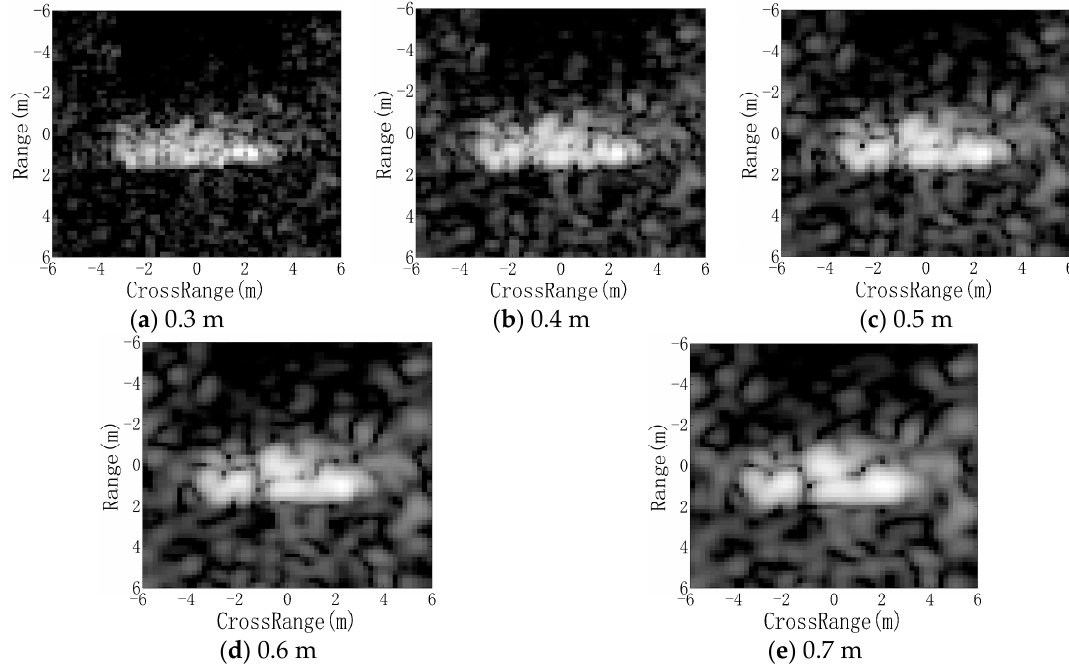
Figure 15. Images at different resolutions.